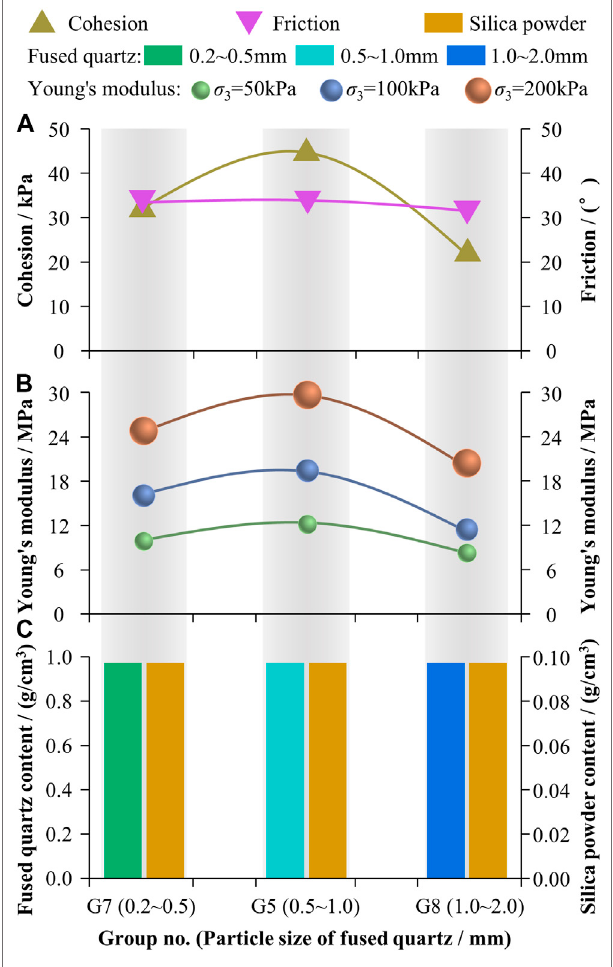
FIGURE11 | Variations in geotechnical parameters ofTCS withdifferent particle gradations of fused